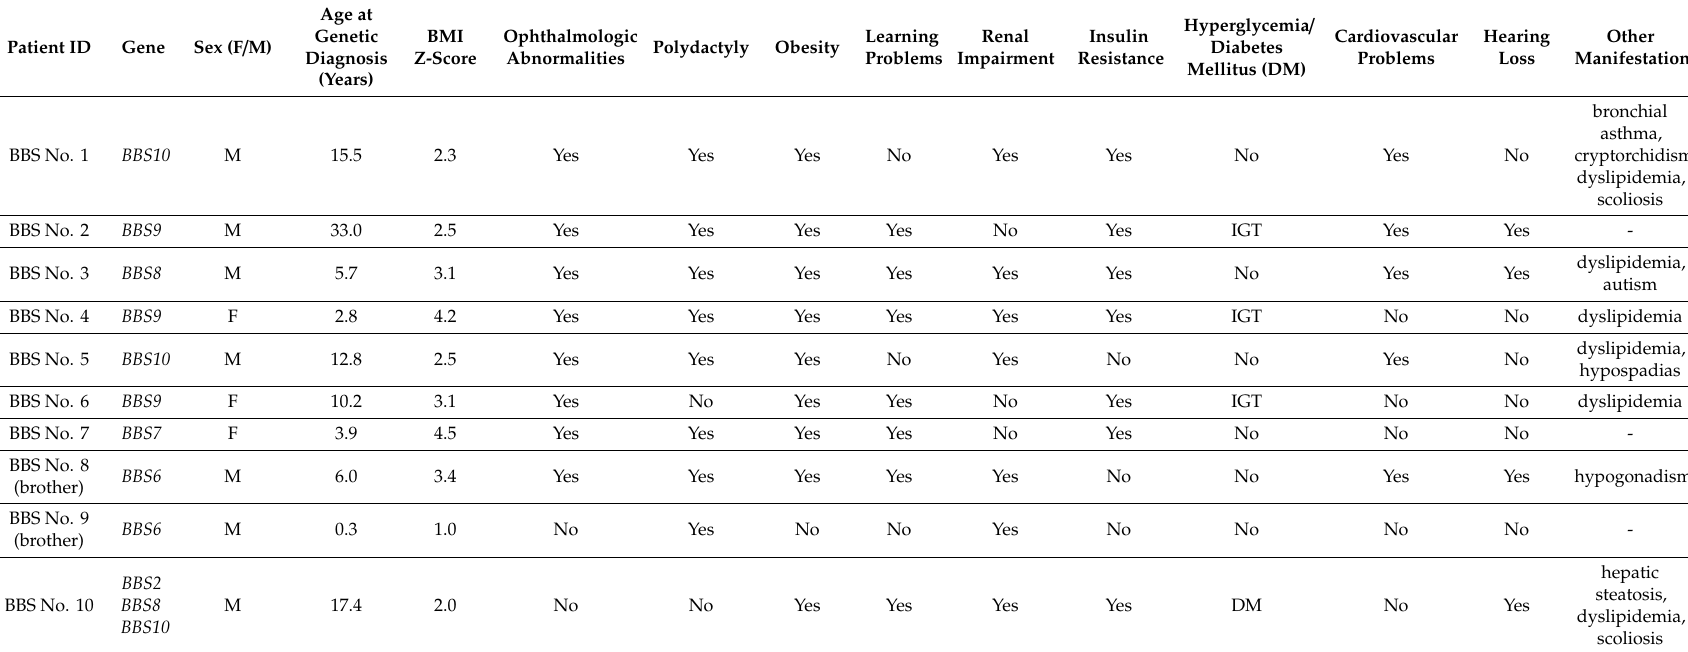
Table 1. Detailed clinical characteristics of the patients with Bardet–Biedl